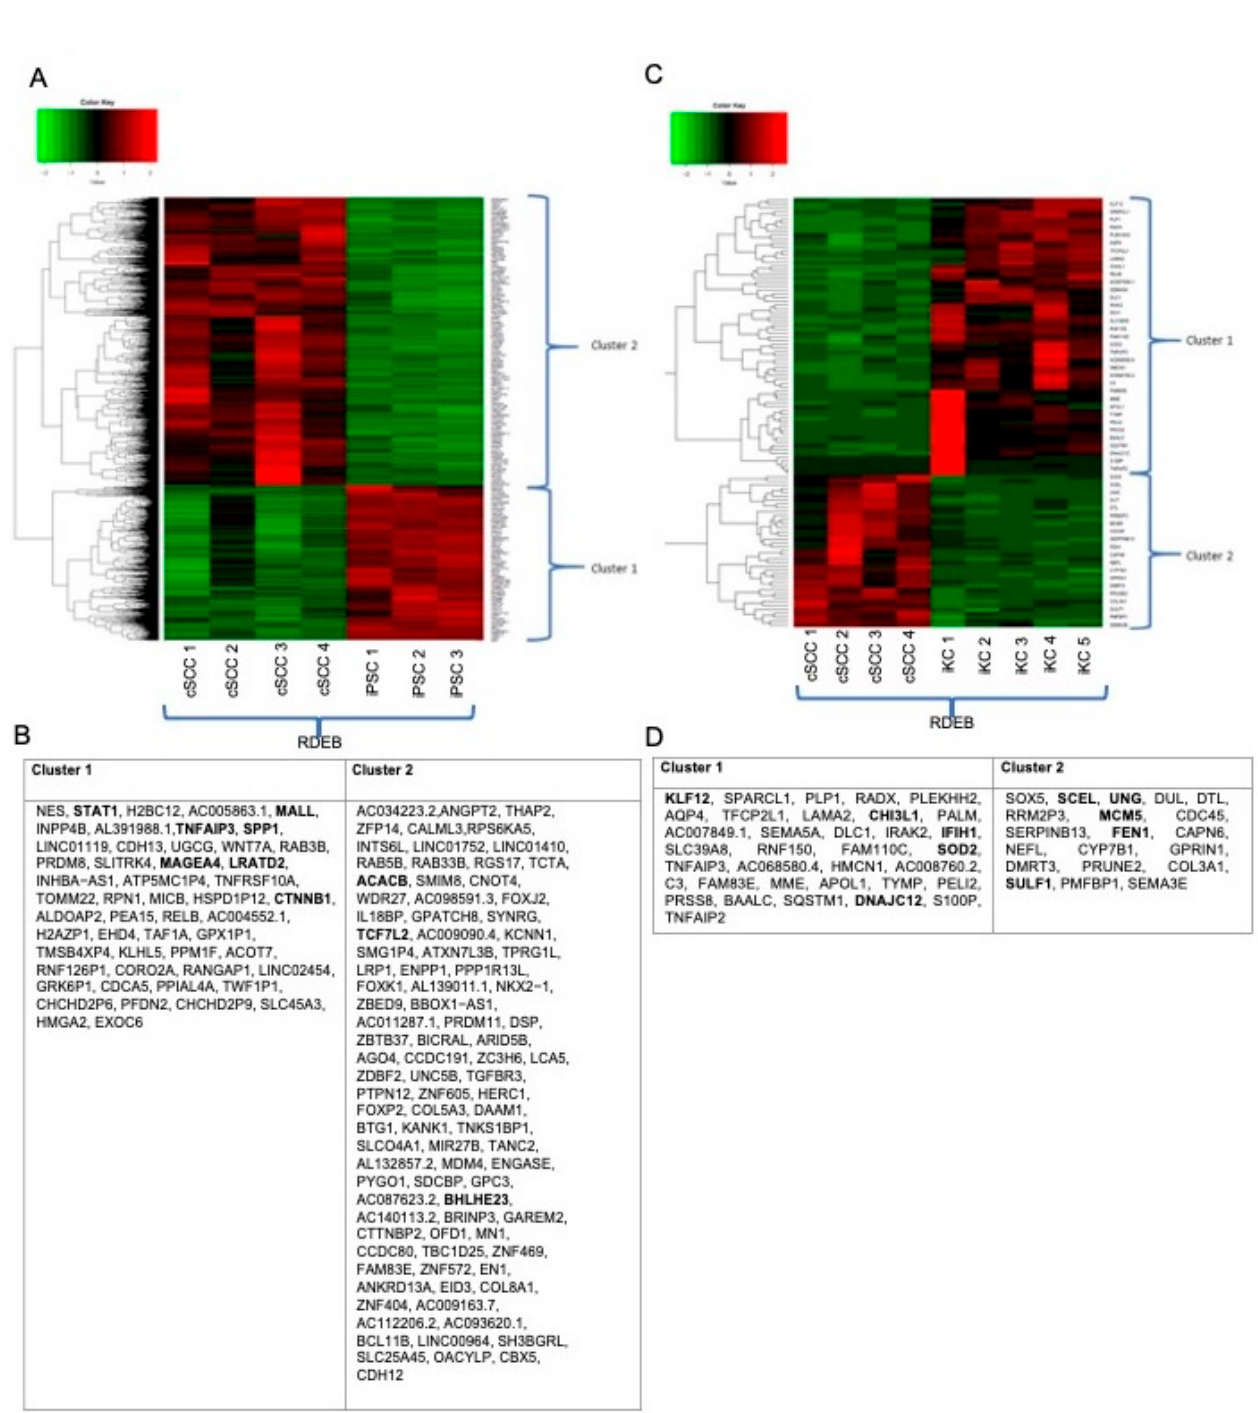
Figure 5. Differential expression analyses. ( A ) Two clusters revealed by differential expression analyses, with opposite expression levels. Left: Differential expression analysis between RDEB-cSCC and RDEB-cSCC-iPSC. ( B )The first cluster includes genes with higher expression in RDEB-cSCC-iPSC, while the second includes genes with lower expression. ( C ) Right: Differential expression analysis between RDEB-cSCC and RDEB-cSCC-iKC. ( D ) The first cluster includes genes with higher expression in RDEB-cSCC-iKC, while the second includes genes with lower expression.